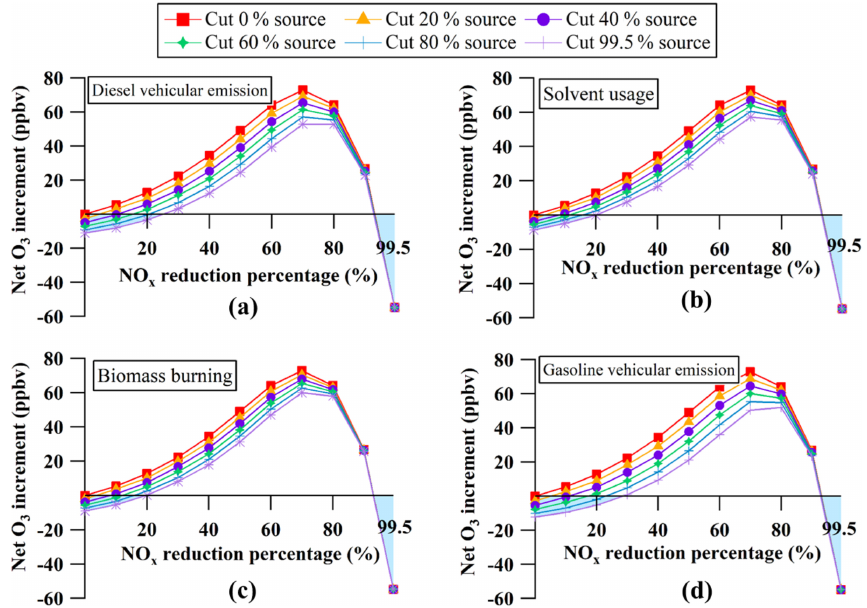
Figure 11. Net O 3 increment as a function of the reduction percentages of NO x for individual sources of volatile organic compounds (VOCs); (a) diesel vehicular emission, (b) solvent usage, (c) biomass burning and (d) gasoline vehicular emission. The highlighted area represents zero O 3